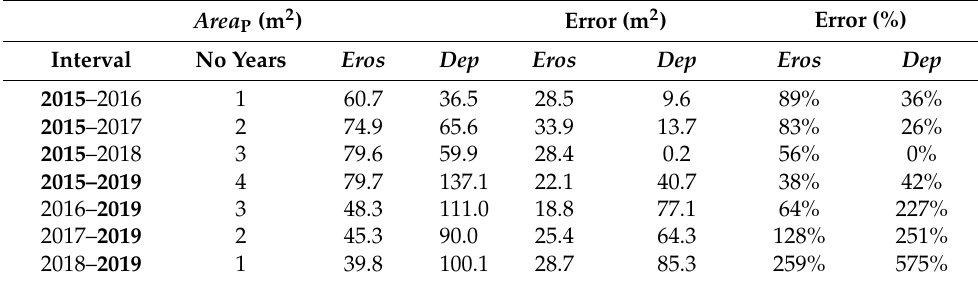
Table A3. Planimetric area Area P of deposition and erosion for each HLS year interval. Errors are relative to equivalent measures from TLS (Table 4). Eros = Areas of Erosion, Dep = Areas of Deposition. Bolded year is reference year used. Data below is represented graphically in Figure 9.